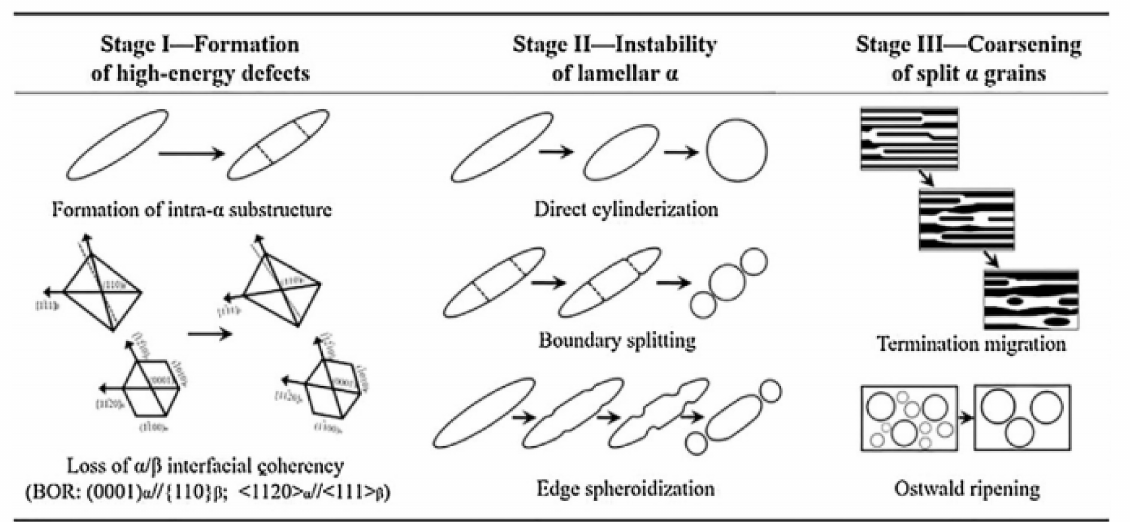
Figure 11. Schematic representation of globularization mechanism of α lamellar. Reprinted from Ref.